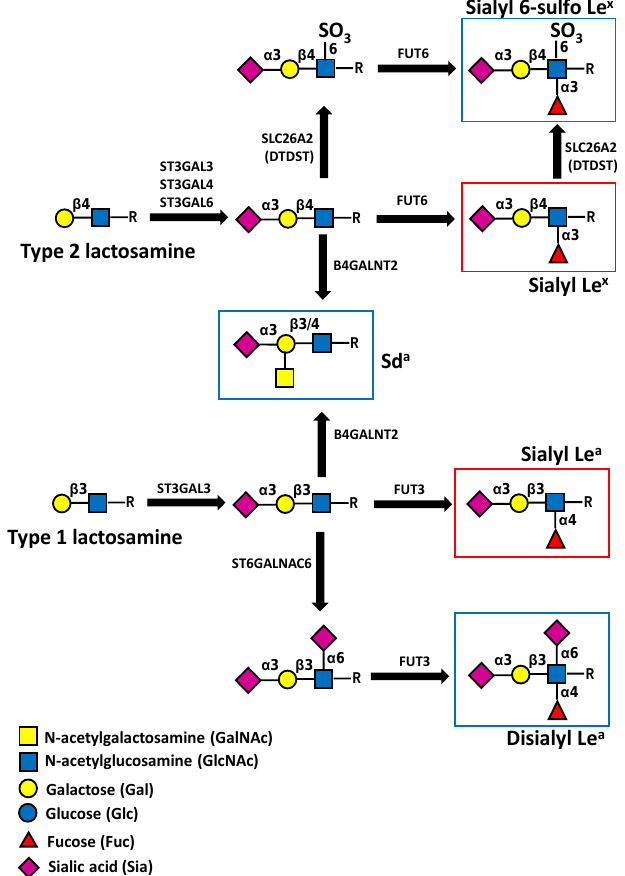
Figure 6. Sialyl Lewis-related antigens and Sd a antigen in colonic tissues. In normal colon, the expression of sialyl 6-sulfo Le x antigen (upper) predominates over that of sLe x . However, the reduced expression of enzymes responsible for its biosynthesis, such as SLC26A2 (formerly DTDST) in colon cancer, leads to the overexpression of sLe x . The biosynthesis of the di-sialyl Le a antigen (lower), which predominates in normal colon, proceeds from α 2,6 sialylation, catalyzed by ST6GALNAC6 , followed by α 1,4-fucosylation mediated by FUT3. The downregulation of ST6GALNAC6 in colon cancer leads to sLe a overexpression. The addition of β 1,4-linked GalNAc mediated by B4GALNT2 leads to the expression of the Sd a , inhibiting that of sLe x and sLe a . Cancer-associated structures are boxed in red, while structures associated with normal colon are boxed in